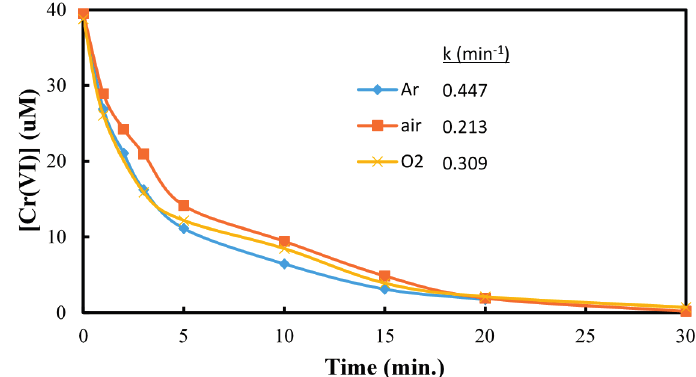
Figure 1. The effect of dissolved argon, oxygen and air on the reduction of Cr(VI).